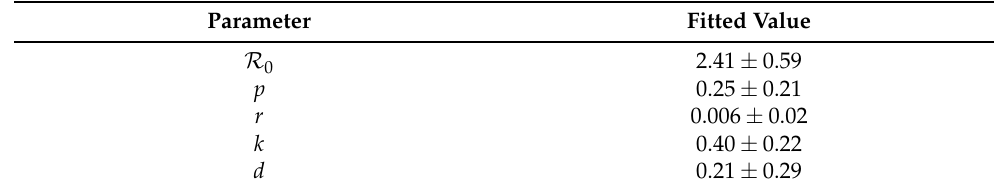
Table 1. Table of the model parameters from the fit; used as a base for extensions. We extend the model with the parameters using hypothetical scenarios for vaccination, relaxation, and the emergence of a variant strain. These give the mean values of the model parameters with one standard